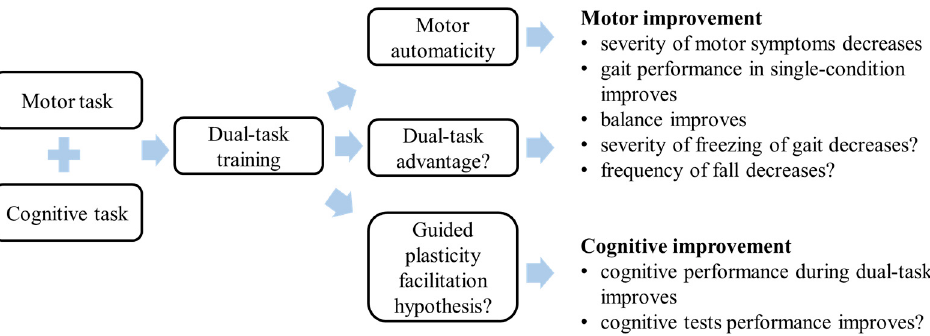
Figure 1. Summary of the motor and cognitive effect of the dual-task training.